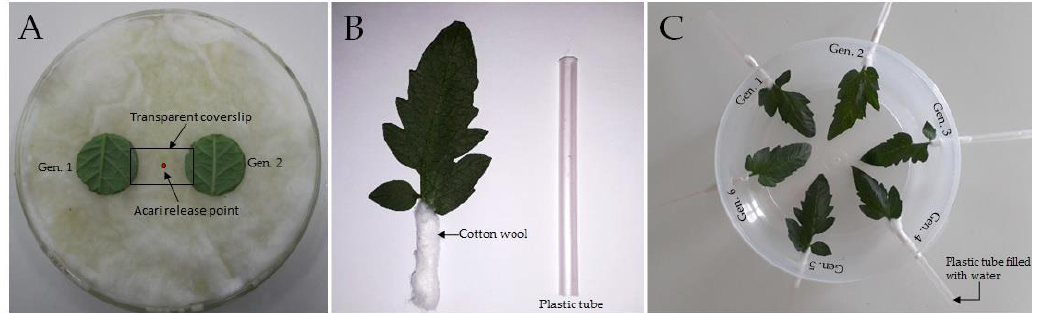
Figure 1. Material used in the host selection bioassays. ( A ) Arena for Tetranychus urticae with two tomato genotypes connected by a transparent coverslip where the mites were released. ( B ) Tomato leaflet wrapped in cotton wool and plastic tube. ( C ) Tomato genotypes (6 treatments) arranged equidistant presenting the design of the Bemisia tabaci and Tuta absoluta bioassays. Each leaflet wrapped in cotton wool was introduced into a plastic tube containing water in order to maintain the humidity.